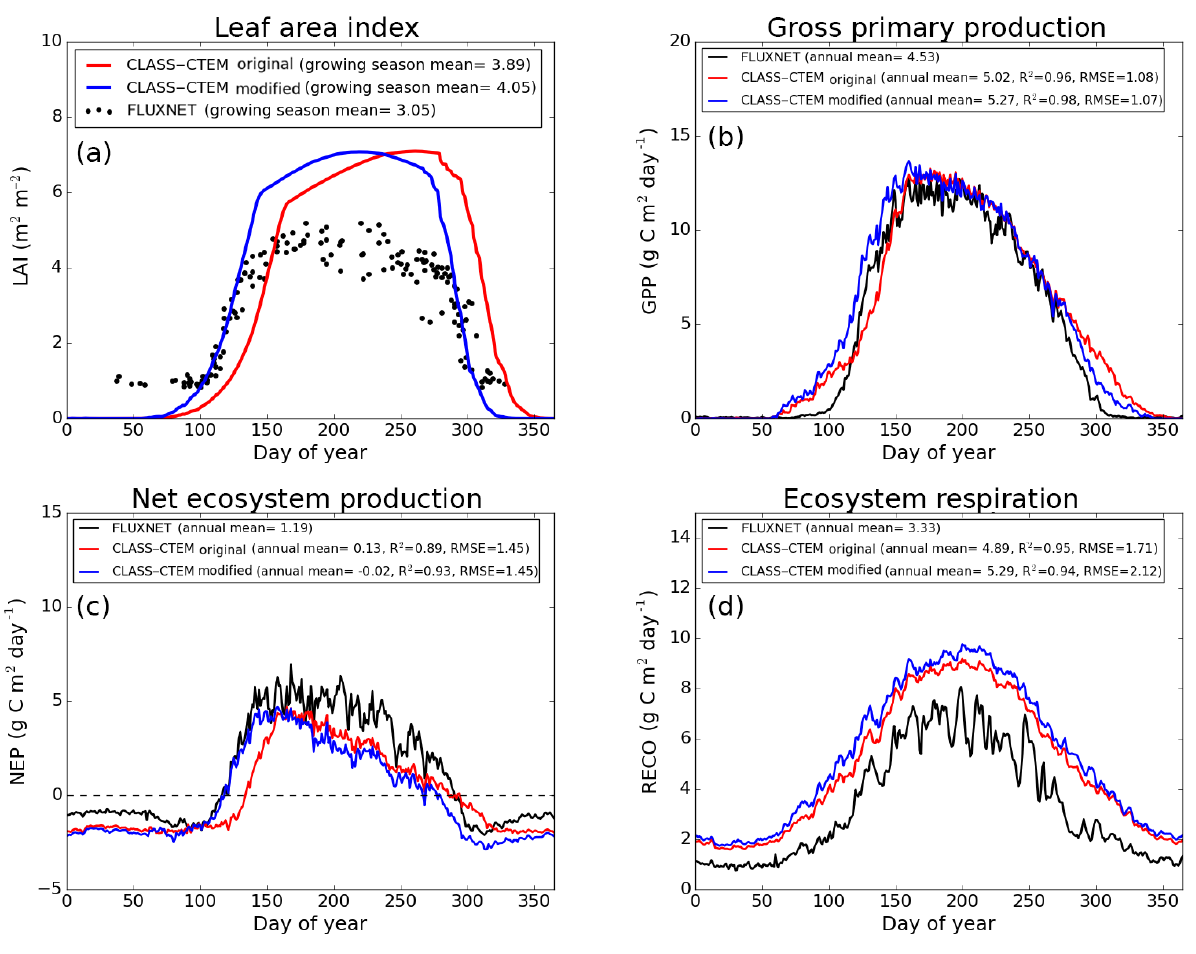
Figure 5. Observed and CLASS–CTEM-simulated averaged daily values of (a) LAI (m 2 m − 2 ), (b) GPP (gCm − 2 day − 1 ), (c) NEP (gCm − 2 day − 1 ), and (d) ecosystem respiration (gCm − 2 day − 1 ) for the US-MMS (Morgan–Monroe State Forest) FLUXNET site across all years when data are present. Legends also show the mean annual value of the quantity plotted, except for LAI, which is averaged over the growing season. Root-mean-square error (RMSE) and coefficient of determination ( R 2 ) are also shown for simulated values when compared to observation-based